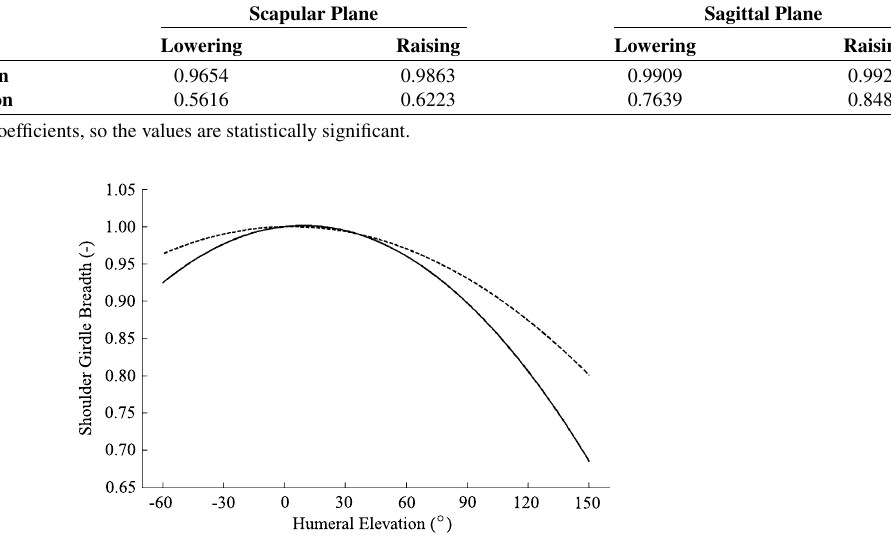
Fig. 6. Comparison of the shoulder girdle breadth vs. humeral elevation from [18] (solid) and this work